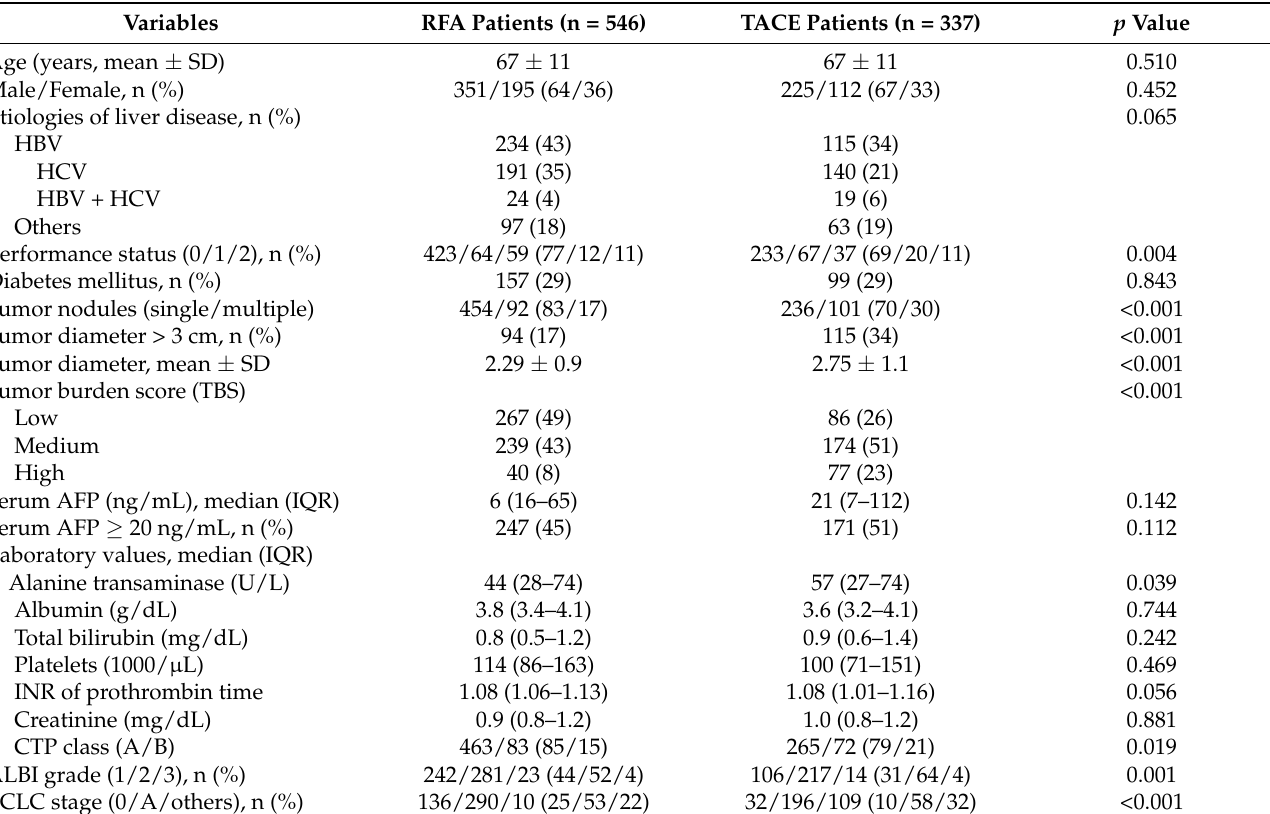
Table 1. Comparison of baseline demographics of patients with HCC within Milan criteria undergoing radiofrequency ablation (RFA) or transarterial chemoembolization (TACE) (n = 883).